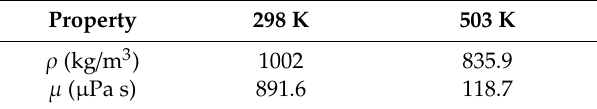
Table 3. Density and viscosity of the water at 298 and 503